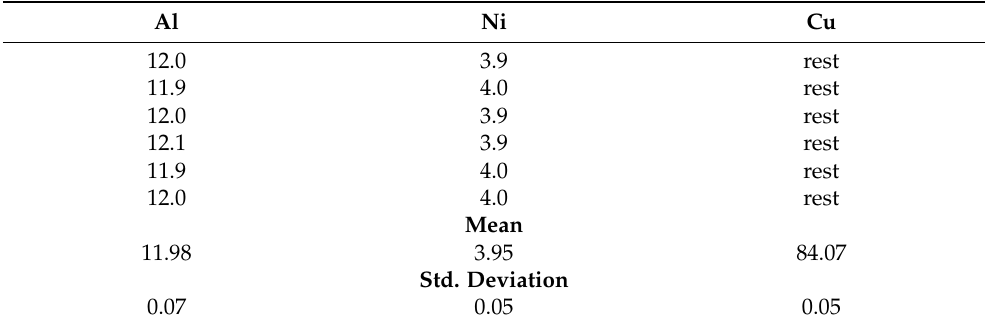
Table 1. ICP-MS chemical composition of Cu-Al-Ni rod (in wt.%). Al Ni